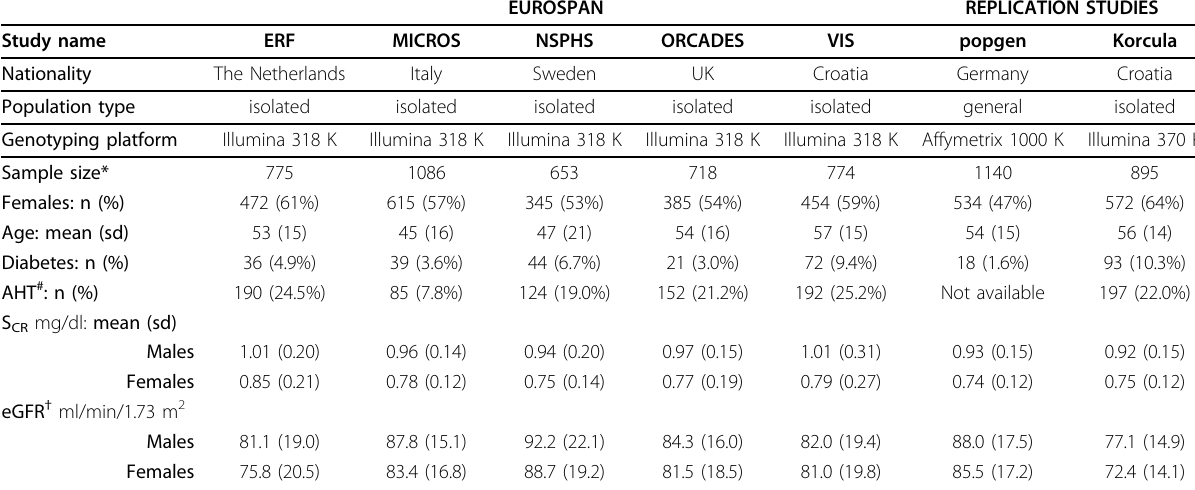
Table 1 Characteristics of studies and study